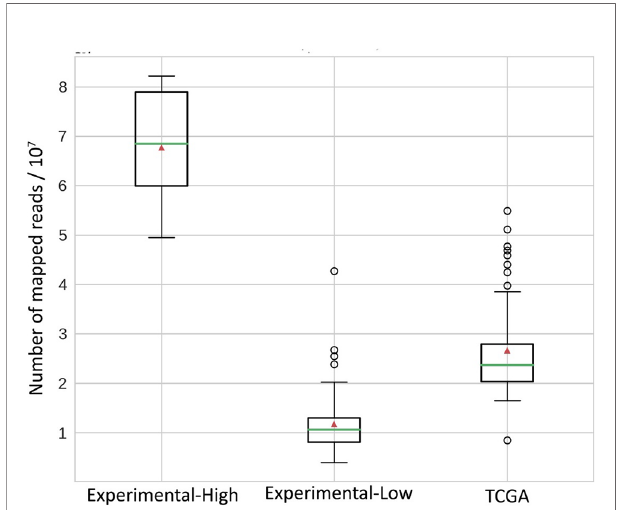
FIGURE 7 | Distribution of mapped reads in RNAseq BAM fi les. All reads were approximately 50 bases long. Green horizontal lines indicate the median, red triangles indicate the